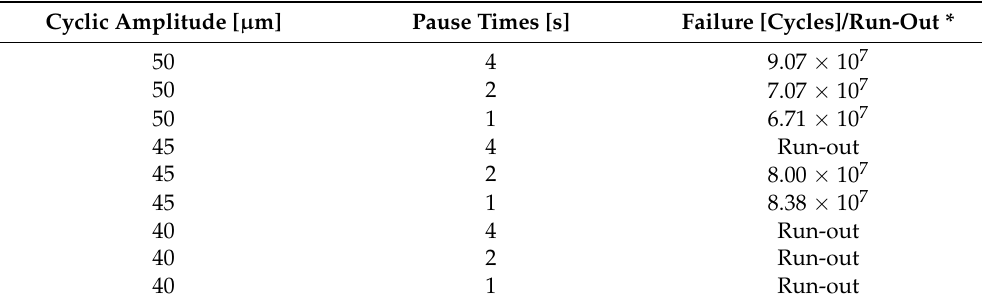
Table 2. The number of cycles to failure and run-outs observed for specimens tested at different cyclic amplitudes and pause times at 20 kHz.